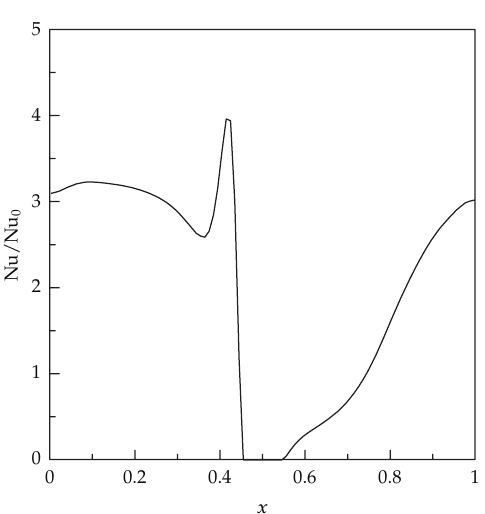
Figure 16: Time-averaged Nusselt number variation at the central transverse mid-plane ribbed wall (cid:2) z (cid:8) 0 . 5 (cid:3) .